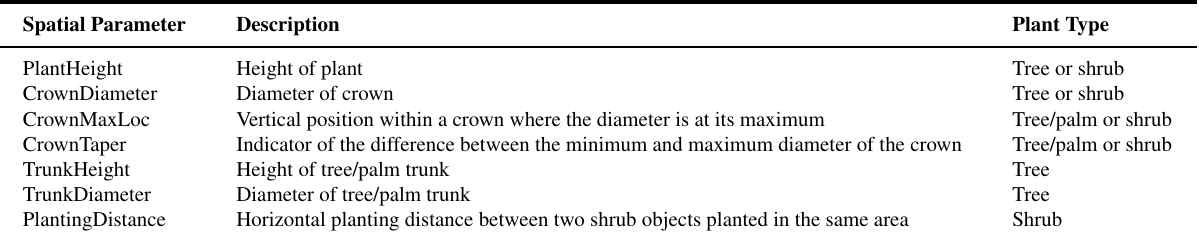
Table 1. Spatial parameters to inform of the size and shape of plant objects